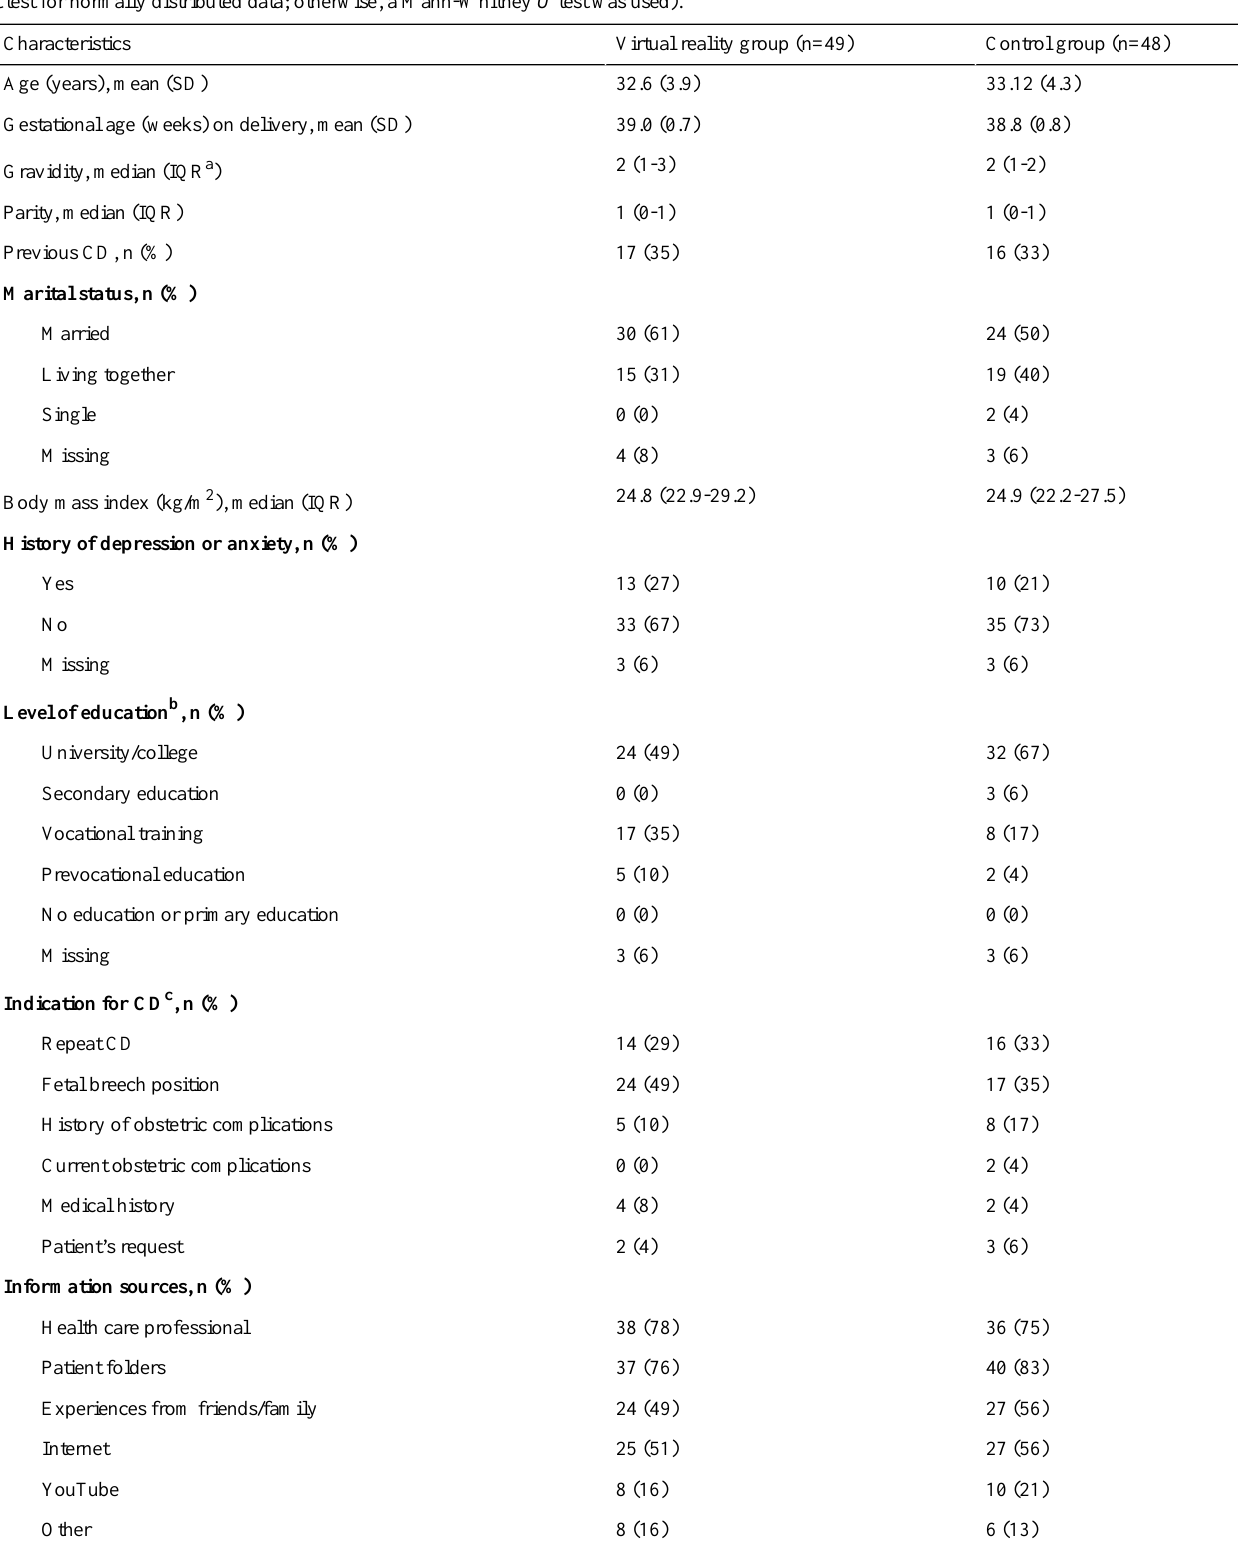
Table 1. Baseline characteristics of women undergoing cesarean delivery for both study groups (probability values were calculated using an independent t test for normally distributed data; otherwise, a Mann-Whitney U test was